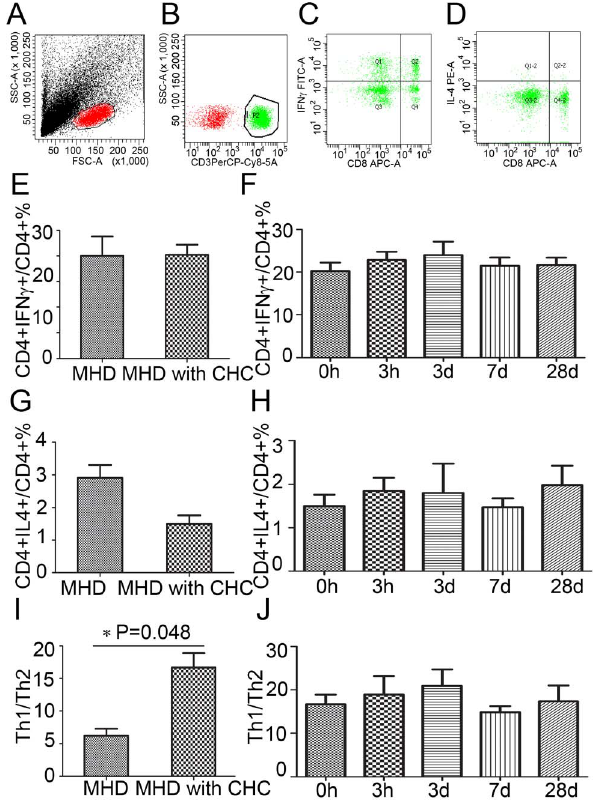
Figure 4. The tendencies of Th1 and Th2 cells in PBMC after the DFPP. A-D. Th1 cells was expressed as IFN- c + CD4 + cells; Th2 cells was expressed as IL-4 + CD4 + cells. E, F The frequencies of Th1 cells in MHD patients with CHC during the DFPP. G, H The frequencies of Th2 cells in MHD patients with CHC during the DFPP. I, J The ratio of Th1 to Th2 cells in MHD patients with CHC.